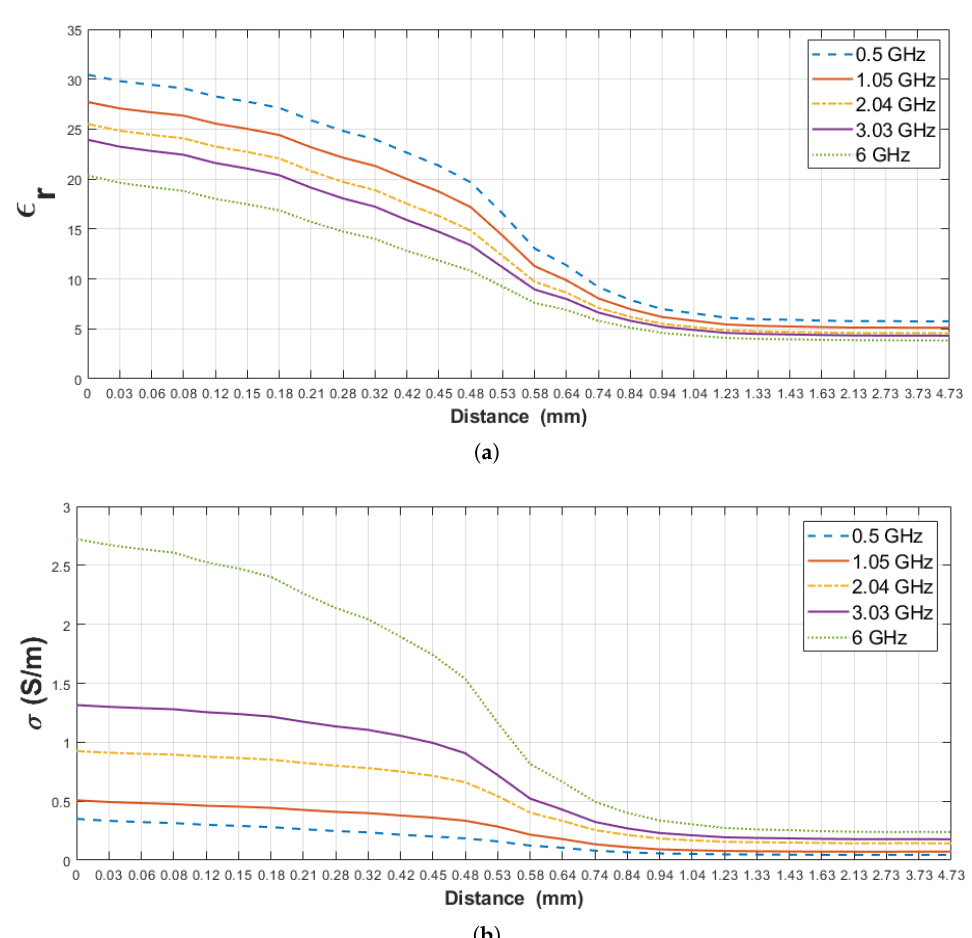
Figure 11. Retrieved dielectric properties of the double-layered rat wet skin tissue and triton X-100 configuration: ( a ) Relative permittivity, ( b ) conductivity as a function of probe’s distance from first layer (D n ) at 0.5, 1.05, 2.04, 3.03 and 6